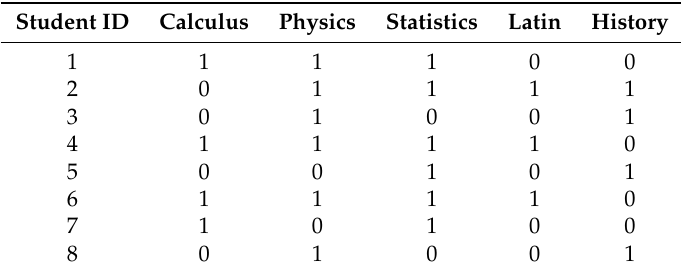
Table 1. An illustrative dataset of class